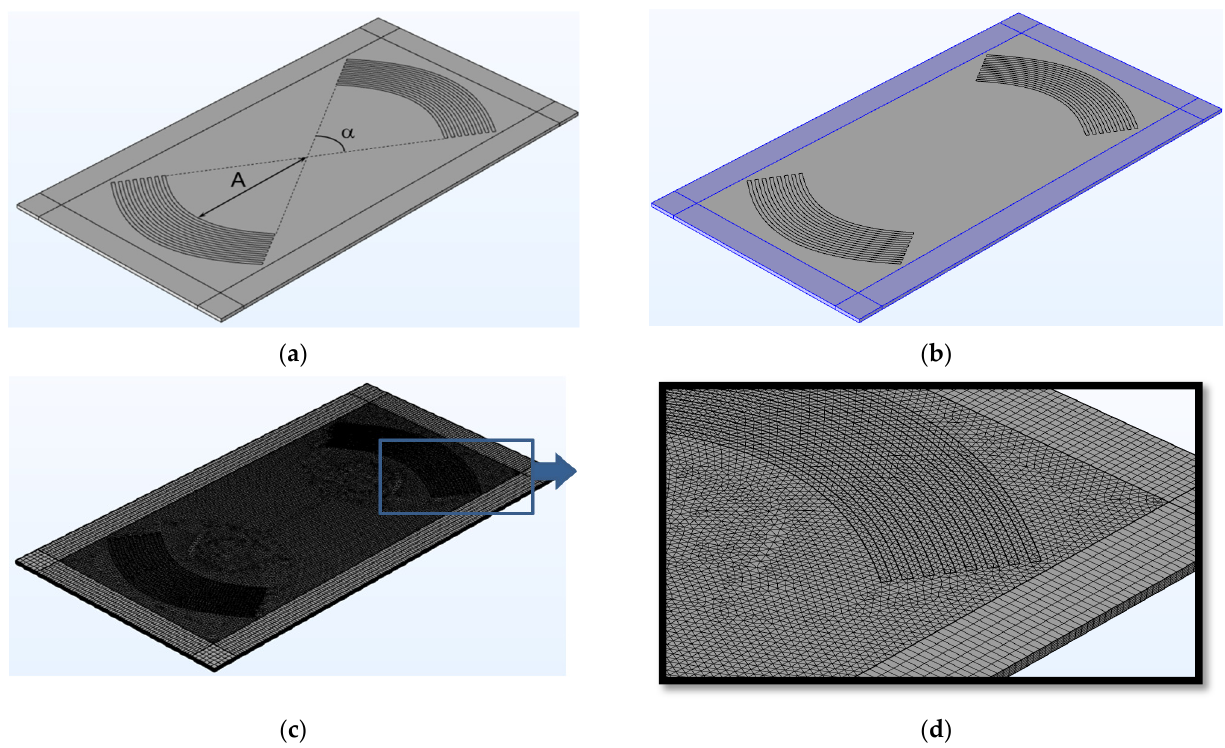
Figure 1. Theoretical model with three-angle grating in the bulk and rectangular grating in the ideally matched zone used for numerical modeling. ( a ) Topology of the FEM model, ( b ) PML location, ( c ) specified mesh of the model, and ( d ) enlarged fragment.